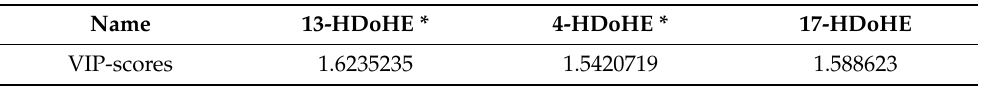
Table 2. Variable importance in projection (VIP) scores are shown for three metabolites. A cutoff value of 1.5 is established for VIP